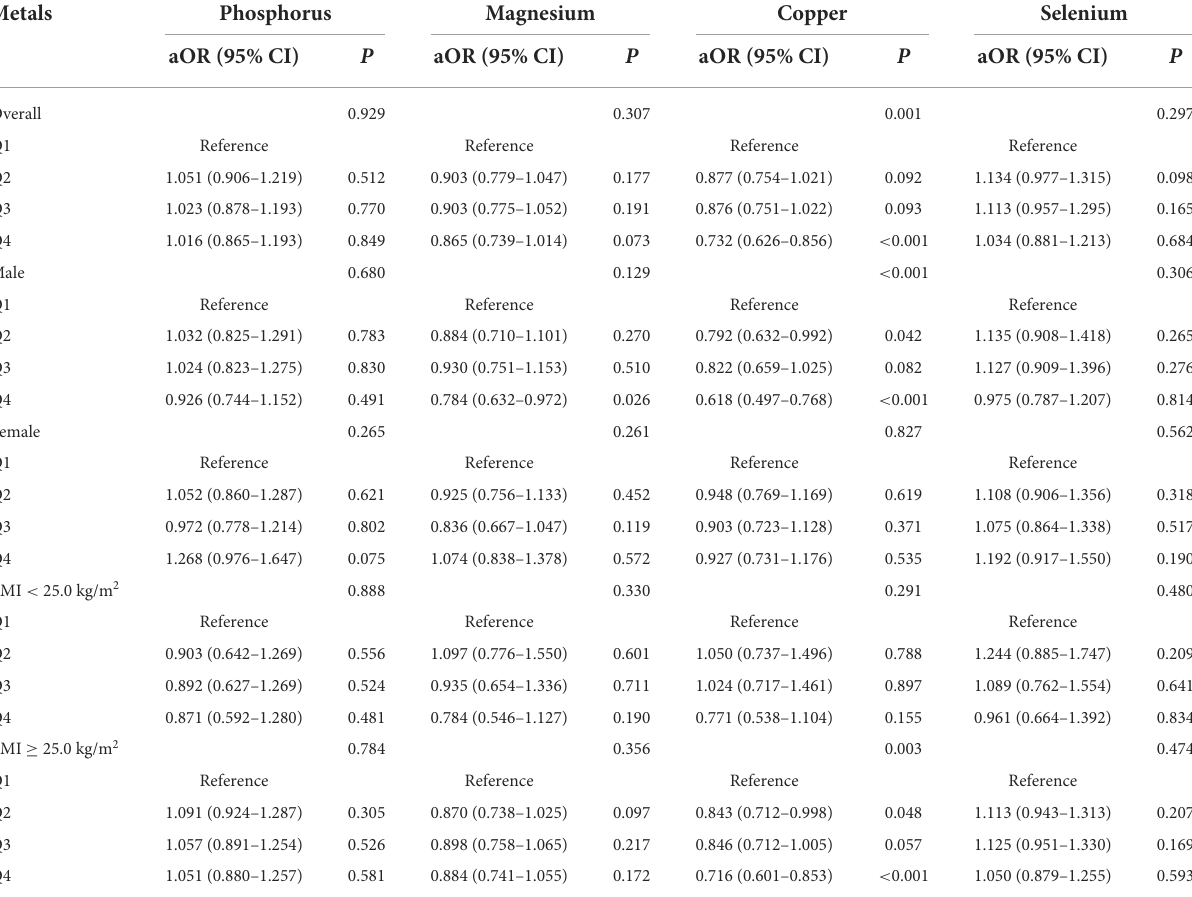
TABLE 4 Multivariate single-metal model logistic regression the relationship between the heavy metals and the presence of kidney stone after